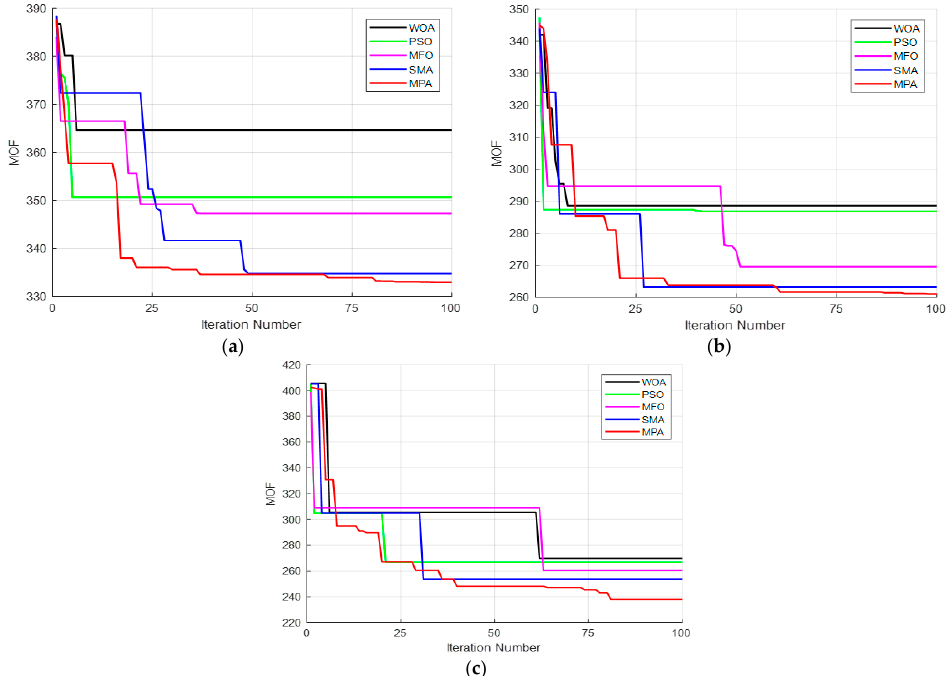
Figure 9. Characteristics of convergence of the algorithms for the IEEE 69-bus: ( a ) PVDG case; ( b ) WTDG case; ( c ) Hybrid PVDG-WTDG case.